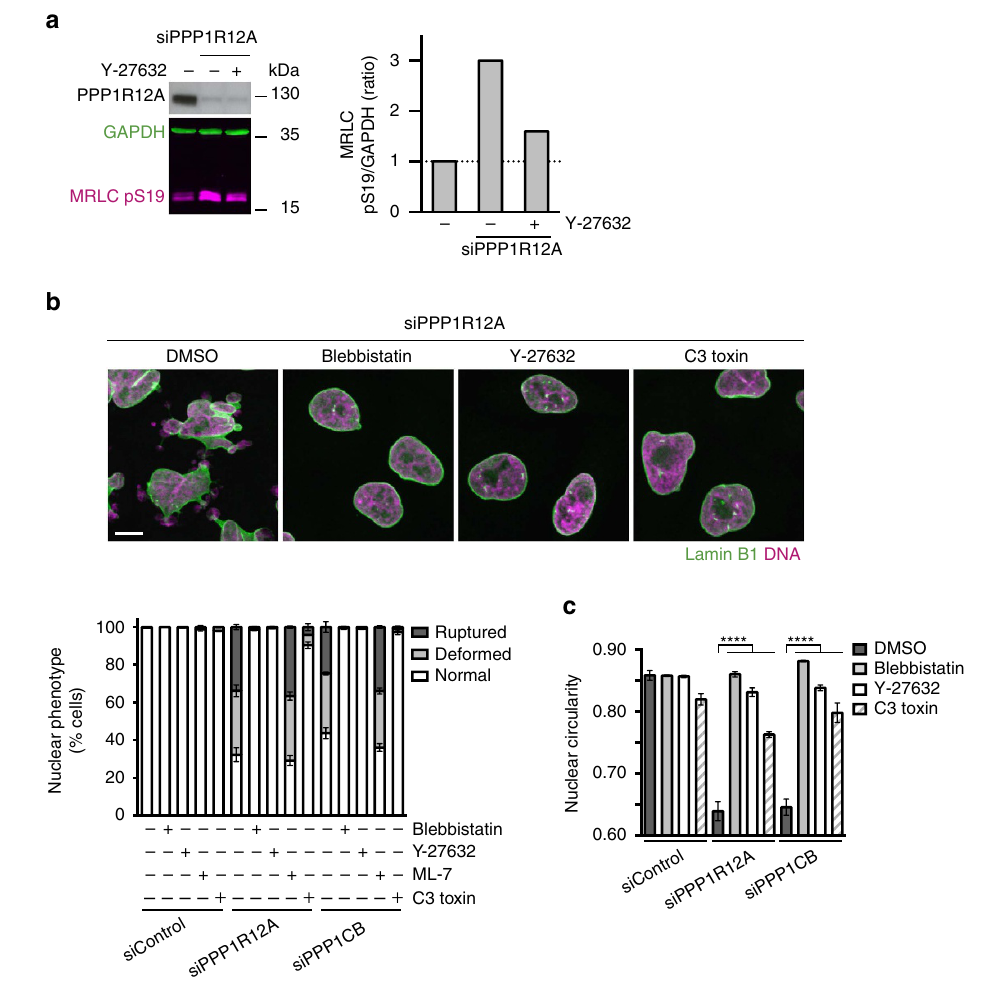
Figure 2 | Actomyosin contractility drives nuclear deformation and rupture in PPP1R12A and PPP1CB-depleted cells. ( a ) HeLa Kyoto cells were harvested 56h after transfection with the indicated siRNA duplexes and analysed by quantitative immunoblotting. ( b , c ) HeLa Kyoto cells transfected with non-targeting control, PPP1R12A or PPP1CB siRNA were fixed 56h after transfection and processed for immunofluorescence analysis. ( b ) siRNA- transfected cells were treated with 5 m M blebbistatin, 5 m M Y-27632, 10 m M ML-7, or 0.4 m gml (cid:2) 1 C3 toxin for 24h before fixation. Representative immunofluorescence images are shown in the top panel. Abnormal nuclear shape (deformed) and nuclear envelope discontinuity (ruptured) are quantified in the bottom panel. Scale bar, 10 m m. ( c ) Quantification of nuclear circularity using the data from images acquired in b . Error bars, s.d. of three independent experiments ( n 4 200 cells each) ( b , c ). Graph shows **** P o 0.0001 (one-way ANOVA Tukey’s multiple comparison